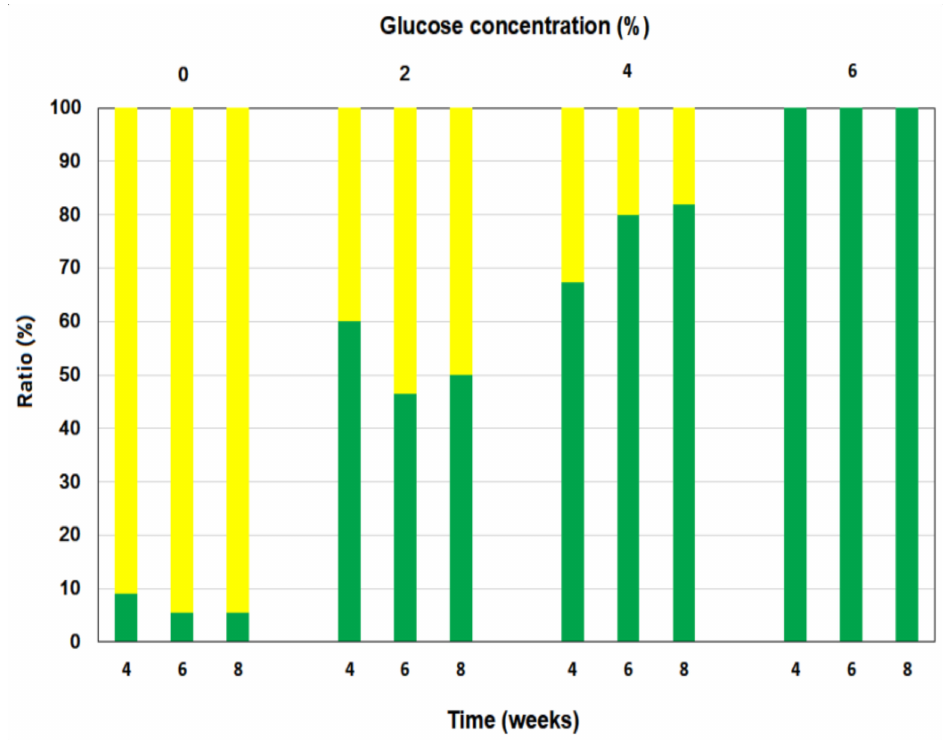
Figure 2. Greening (including green-tinted color) ratio of newly developed leaves of Pachira macro- carpa plants grown in complete darkness. Green bar, green leaf ratio; yellow bar, pale-yellow leaf